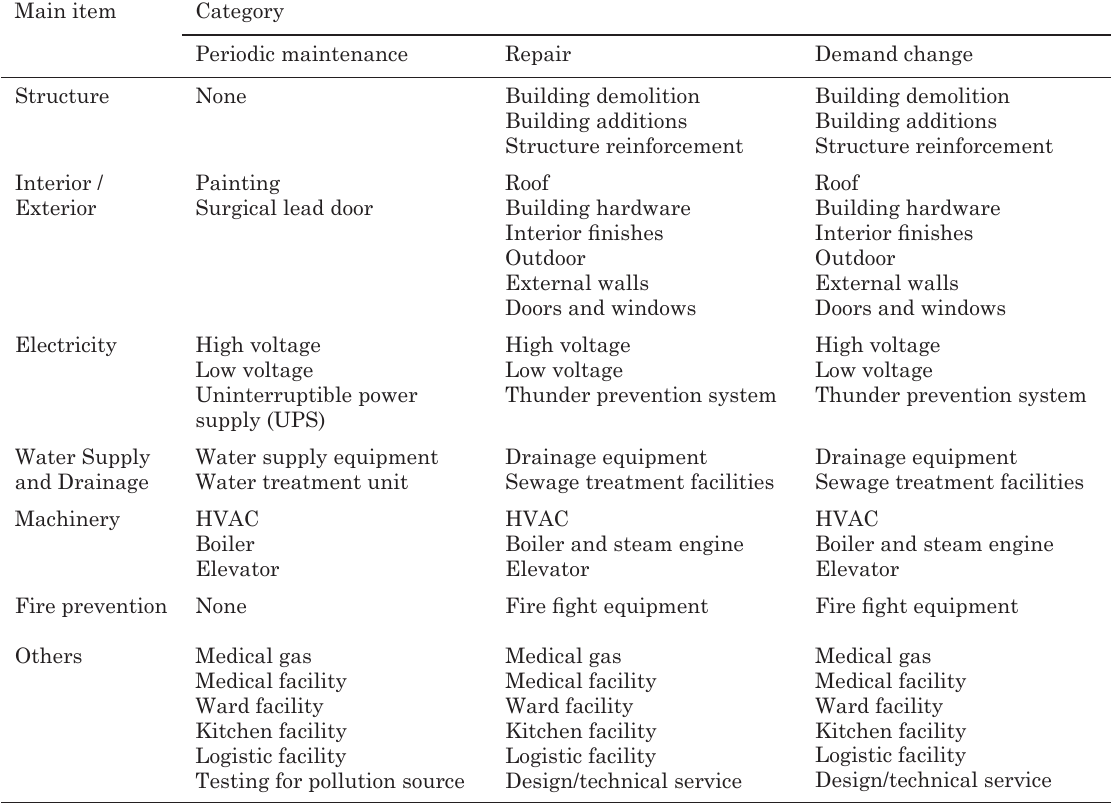
table 1. Maintenance records classification matrix